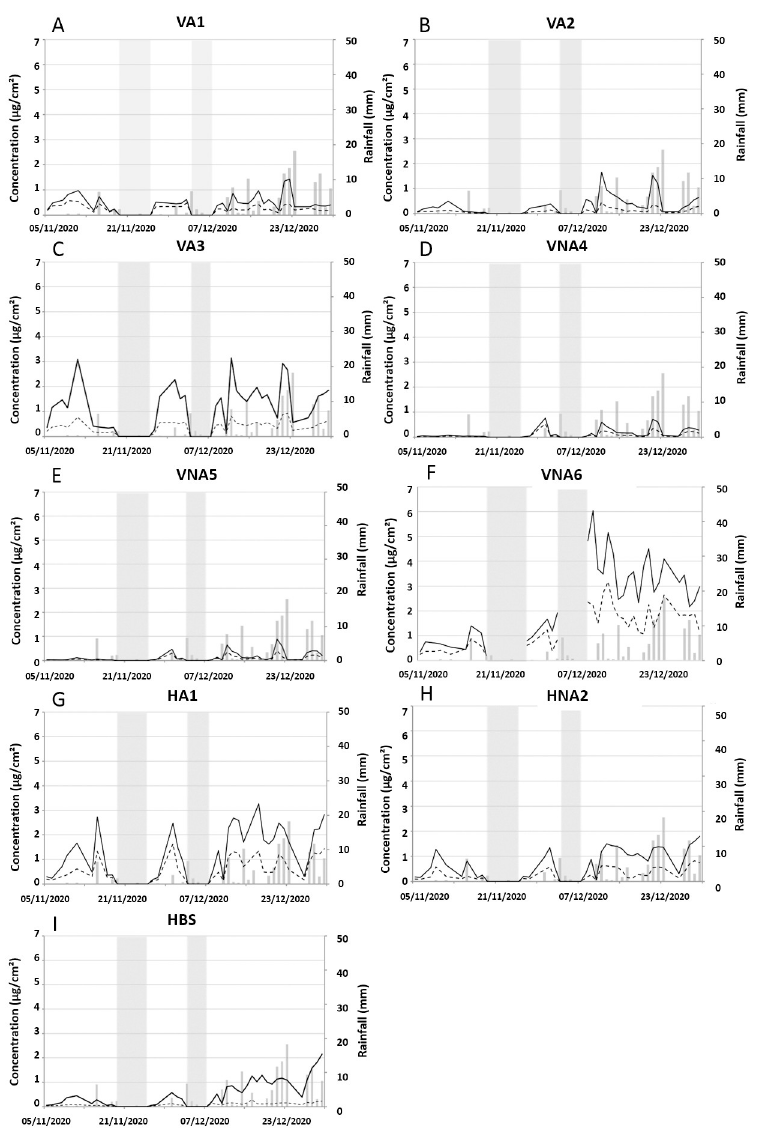
Fig 4. Evolution of microbial concentration (cyanobacteria and green algae) associated with rainfall event in the fall-winter season. For vertical sheltered (VA1 (A), VA2 (B), VA3 (C)), vertical non-sheltered (VNA4 (D), VNA5 (E), VNA6 (F)), horizontal positions (HA1 (G) and HNA2 (H)) and bleach washed tiles (HBS (I)). Each point and bar represent the mean and standard deviation based on three replicates. Grey zones correspond to the absence of